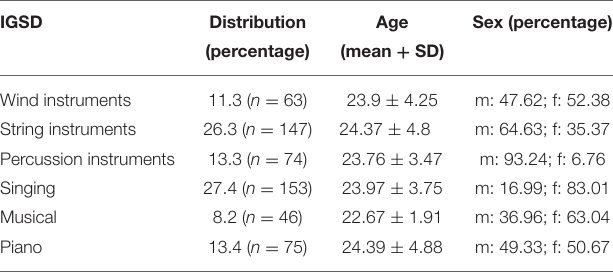
TABLE 2 | Age and sex depending on IGSD.